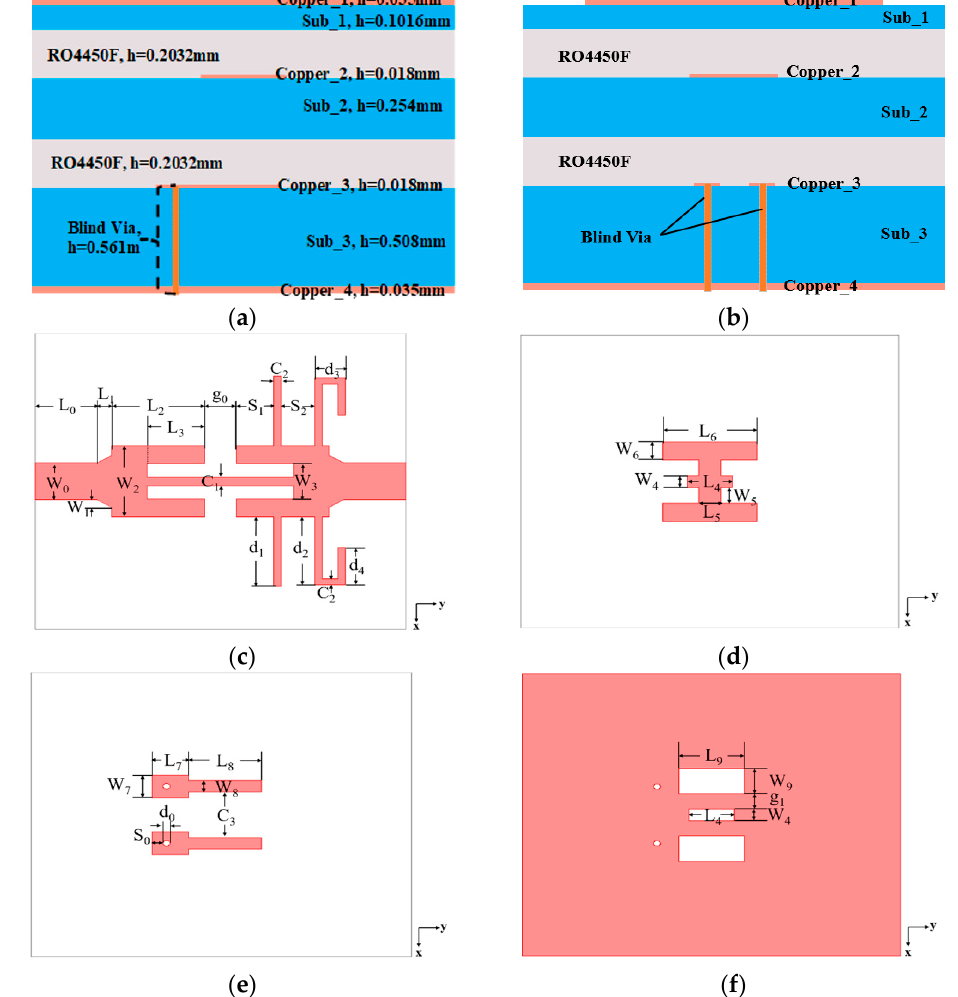
Figure 1. ( a ) Side view of filter structure; ( b ) Front view of filter structure; ( c ) Structure of top coupling patch, Copper_1; ( d ) Structure of second coupling patch, Copper_2; ( e ) SIR structure of the third layer, Copper_3; ( f ) Ground layer of DGS, Copper_4.